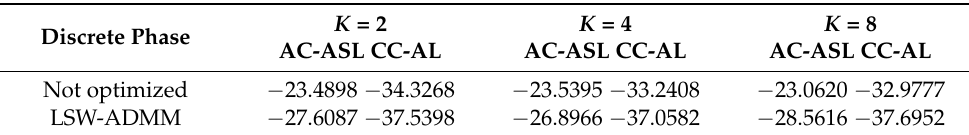
Figure 11. Cross-correlation of the subpulses of the FSK-PSK signals before and after optimization. ( a ) Cross-correlation of sub-pulse 1 and 2. ( b ) Cross-correlation of sub-pulse 1 and 3. ( c ) Cross- correlation of sub-pulse 1 and 4. ( d ) Cross-correlation of sub-pulse 2 and 3. ( e ) Cross-correlation of sub-pulse 2 and 4. ( f ) Cross-correlation of sub-pulse 3 and 4. Table 5. AC-ASL and CC-AL of the FSK-PSK signal before and after optimization (unit: